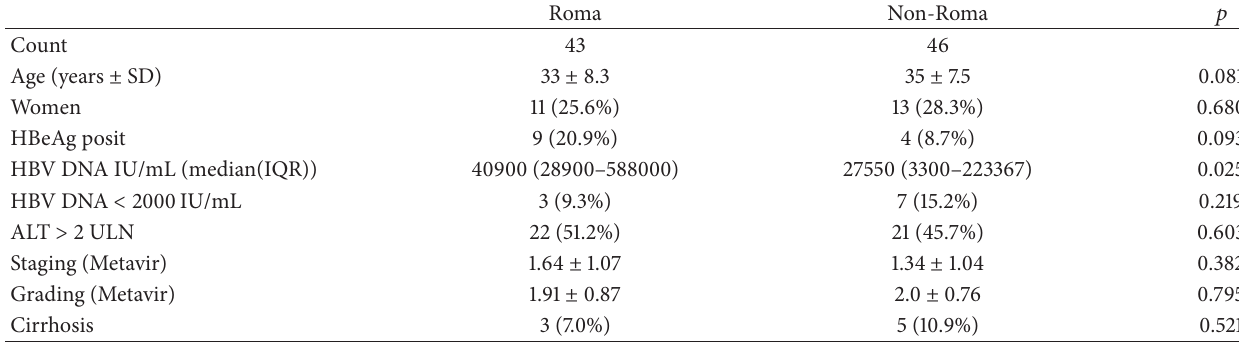
Table 1: Baseline demographic and virological parameters of the study